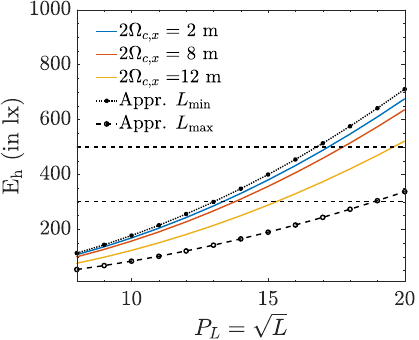
Figure 3. Number of LEDs required to achieve E h , Φ typ v = 270